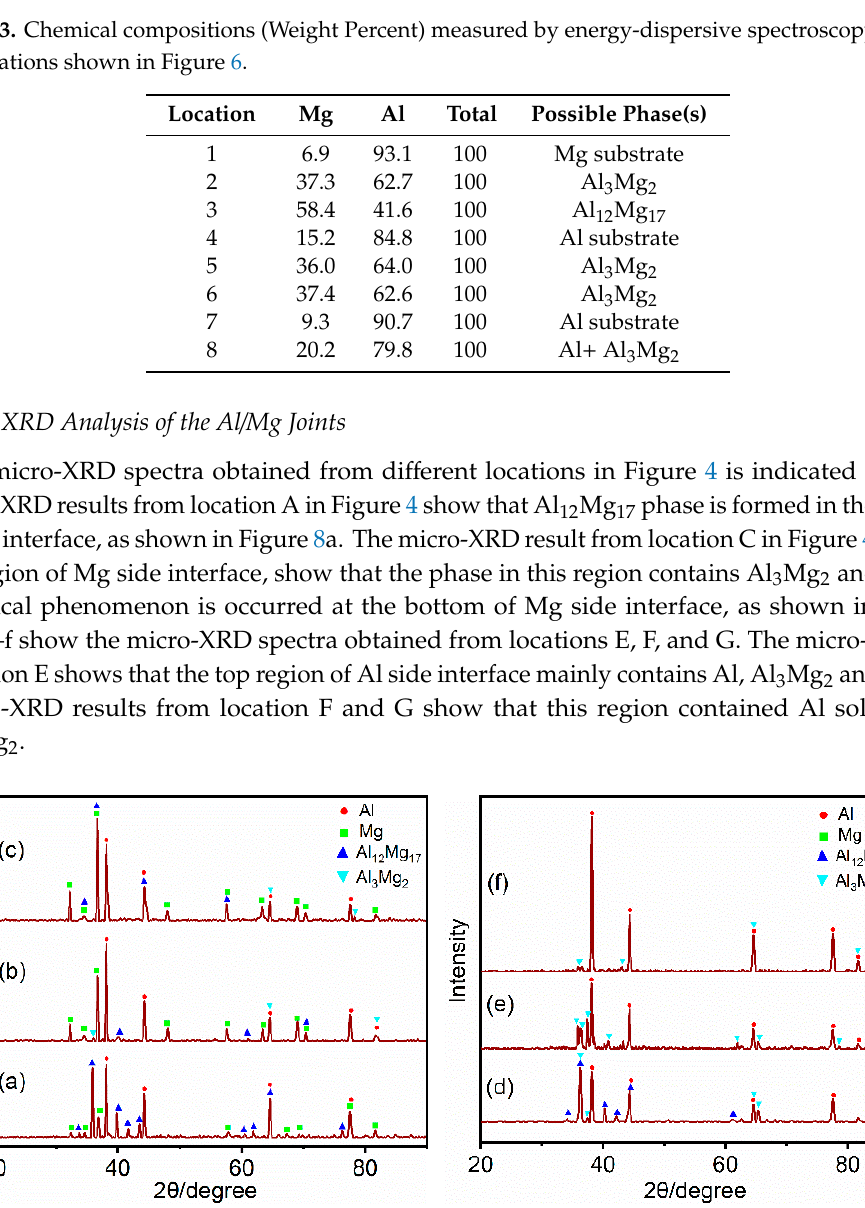
Figure 8. Micro-XRD spectrums from different positions shown in Figure 4: ( a – f ) represent the location A, C, D, E, F and G, respectively.